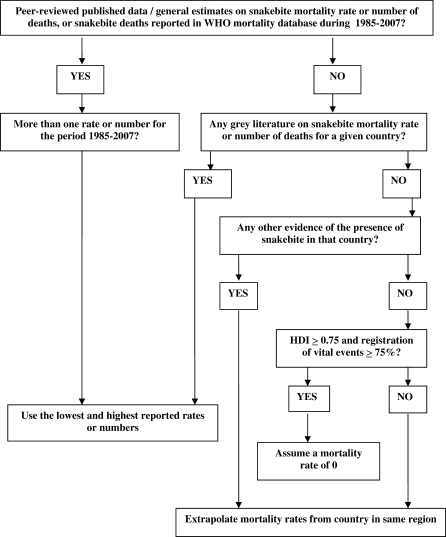
Algorithm for Calculation of Mortality Due to Snakebite